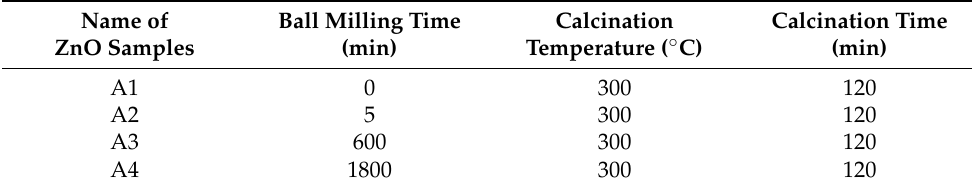
Table 8. Names and preparation conditions of the ZnO